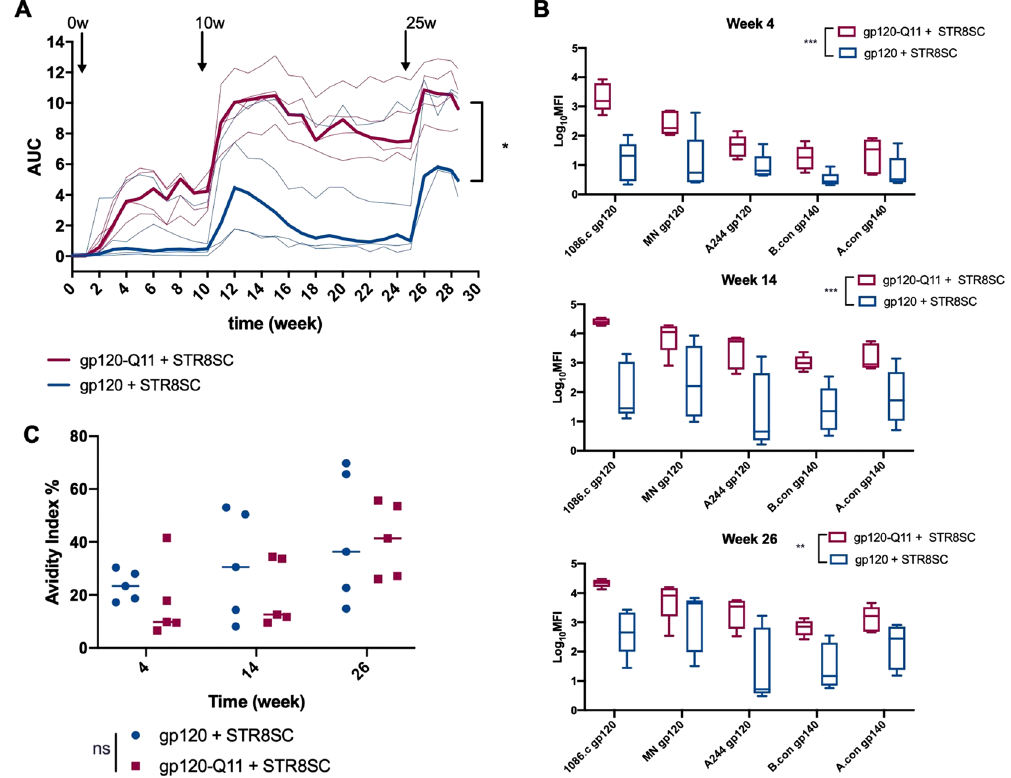
Figure 3. Multivalent display of proteins increases titers and heterologous binding when formulated with adjuvant. ( A ) Magnitude of serum antibody responses to gp120 from mice immunized with gp120 or gp120 nanofibers adjuvanted with STR8SC at times indicated by arrows as measured by ELISA. Bold line shows mean titer and thin lines show individual responses. Mice received 3 total immunizations of 15 μg gp120 each. Compared using a linear mixed effects model, * p < 0.05. ( B ) Binding of serum antibodies to a panel of heterologous antigens at 4, 14, and 26 weeks post immunization. Groups were compared using GEE (see methods for more detail). ** p < 0.01, *** p < 0.001. ( C ) Avidity index of serum antibodies to gp120 measured by binding of antibodies under denaturing conditions. Groups were compared using a repeated measures non- parametric test and no significant difference was